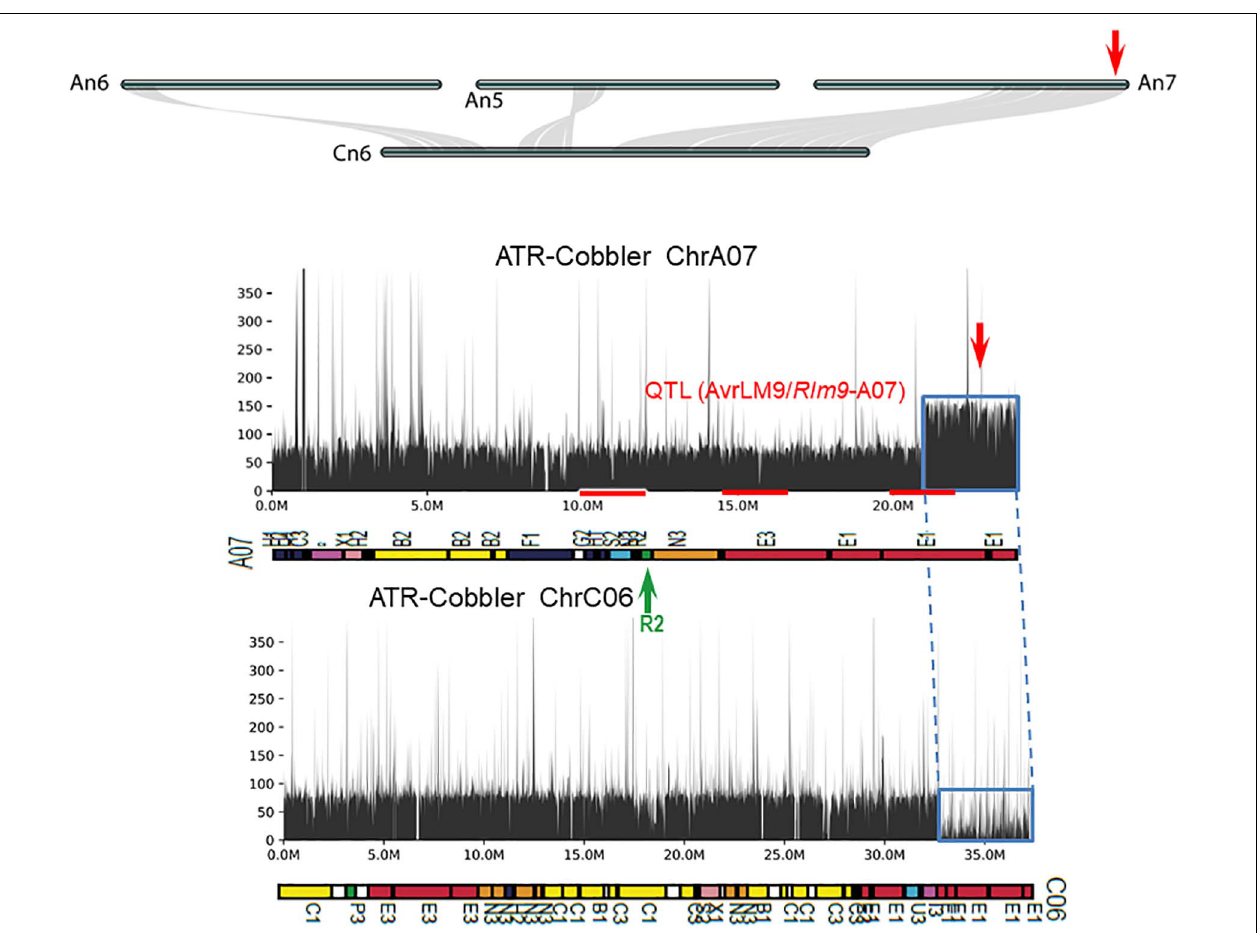
FIGURE 6 | Syntenic relationships between homoeologous chromosome harboring LepR4 and Rlm9 genes for resistance to L. maculans . The gene syntenies between A05, A06, A07, and C06 are shown with gray connections. The Rlm9 region maps to 15.1 Mb of the Darmor- bzh sequence and is marked in red. The coverage depth of homoeologous chromosomes was calculated after mapping resequenced reads to the Darmor- bzh genome assembly version 4.1. Gene syntenies show that in ATR-Cobbler, the coverage depth of the C06 region is almost nil, while in A07, the coverage depth is more than double, illustrating the occurrence of HE between A07 and C06. The syntenic region, subjected to HE, is marked with dotted/solid lines (in blue). Gene sequences which were located in different ancestral blocks are also marked in different colors. Localization of marker sequences to ancestral blocks was carried out using the method described previously (Zou et al.,